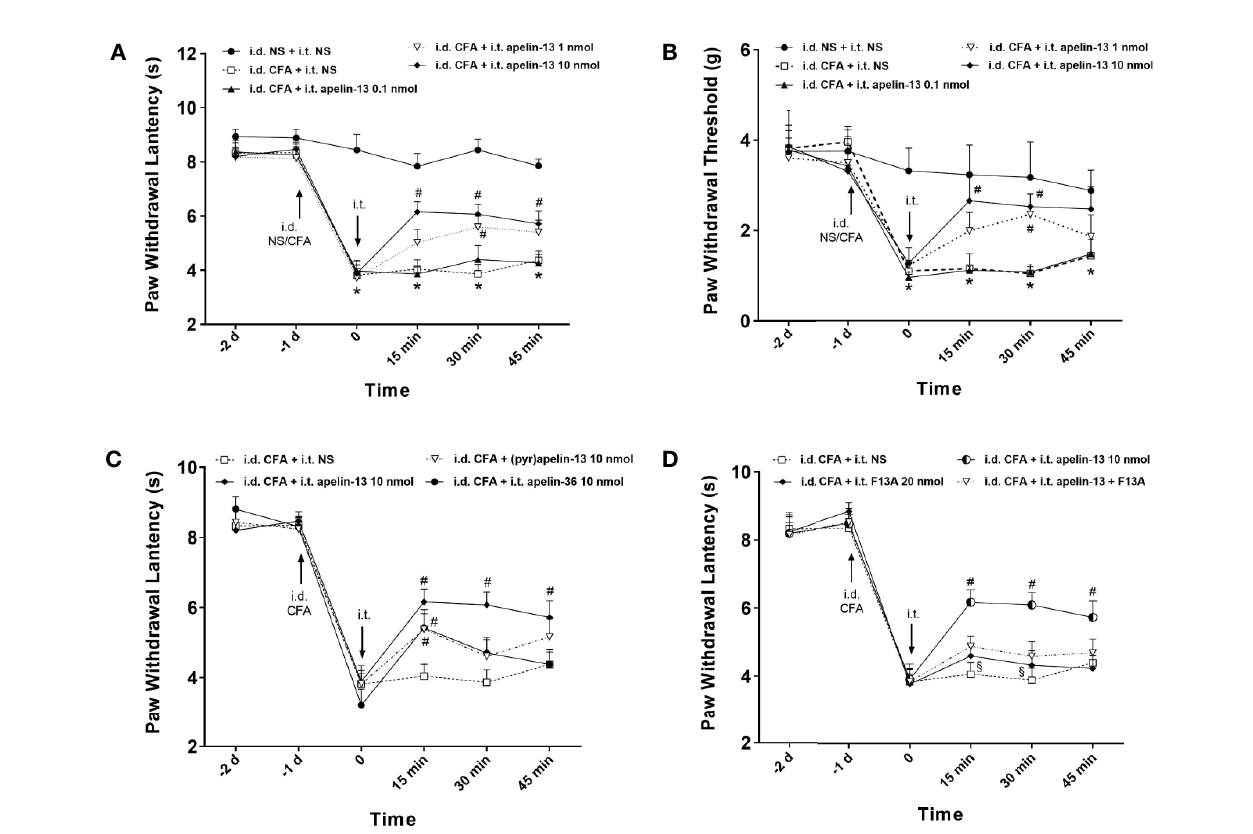
FIGURE 2 | I.T. injection of apelin alleviated the in fl ammatory pain induced by intradermal injection of CFA in mice. Normal saline (NS) was used as a control. The upward and downward arrows indicate the time points when i.d. and i.t. injection were administered. (A, B) Effect of apelin-13 (0.1, 1 and 10 nmol/mouse, i.t.) on PWL in response to thermal stimulation and PWT in response to Von Frey fi lament stimulation. (C) The effect of i.t. application of 10 nmol apelin-13, (pyr)apelin-13 and apelin-36 on PWL. (D) Effect of APJ receptor antagonist apelin-13(F13A) (20 nmol/mouse) on antinociception of (pyr)apelin-13 (10 nmol/mouse). Data are expressed as means ± SEM. n = 6 – 10 per group. * p < 0.05, compared with vehicle control (i.d. NS + i.t. NS); # p < 0.05, compared with CFA group (i.d. CFA + i.t. NS); § p < 0.05, compared with apelin-13-treated group (i.d. CFA + i.t. apelin-13). F13A,